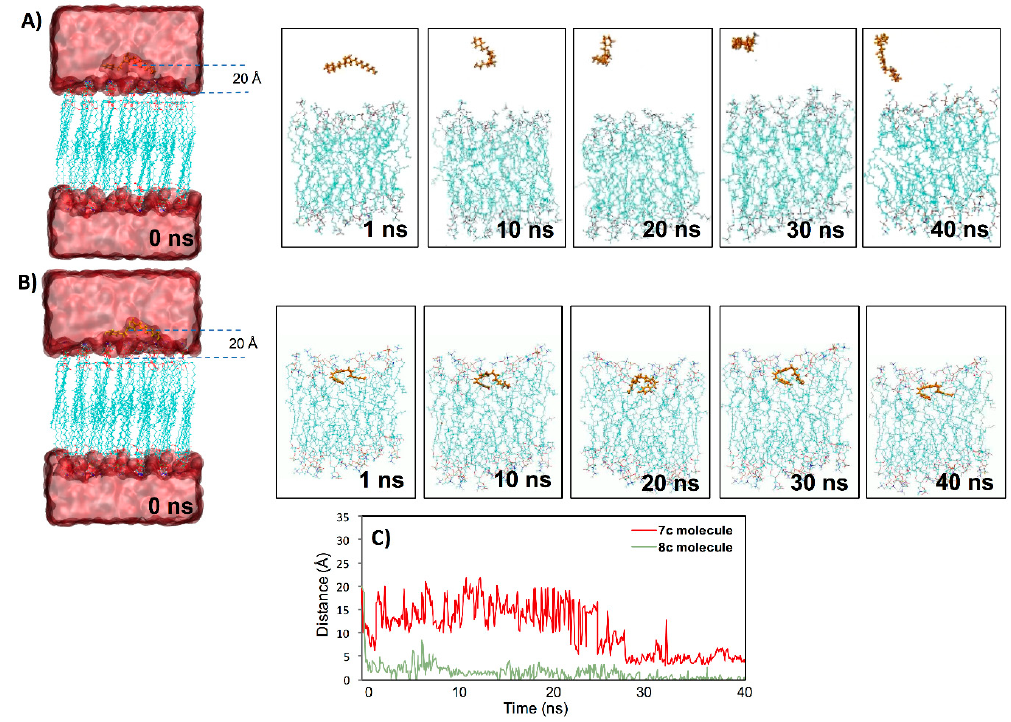
Figure 2. Interaction between 7c and 8c molecules with a lipid bilayer. Incorporation and interaction of the 7c ( A ) and 8c ( B ) molecules in the membrane along with 40 ns of the molecular dynamic (MD) simulation. In the figures ( A ) and ( B ) over time, the water molecules were removed to improve visualization. ( C ) Minimum distance obtained from two independent MD simulations, between the mass center of the 7c and 8c molecules and the surface of the lipid bilayer.